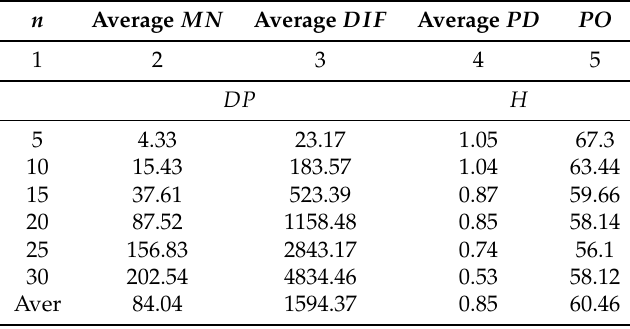
Table 2. Average results with Algorithm DP and Heuristic H for the 30,000